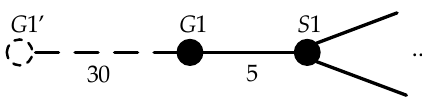
Figure 2. A weighted graph representing a power system.